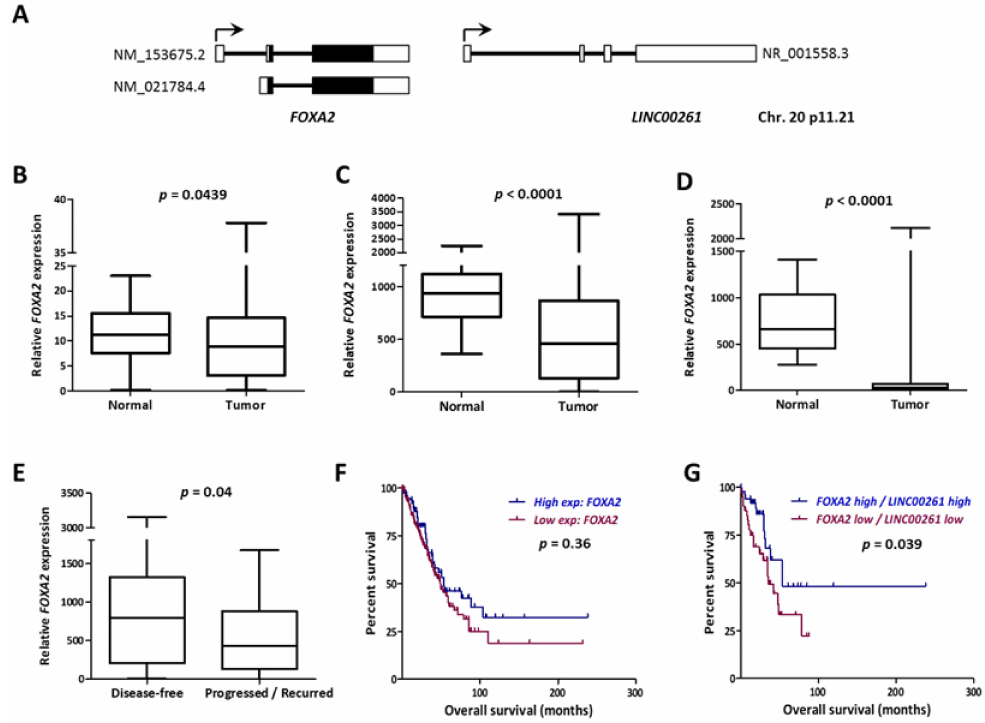
Figure 3. FOXA2 gene neighboring LINC00261 is co-downregulated in lung cancer. ( A ) The FOXA2 / LINC00261 gene locus on the small arm of human chromosome 20. Black boxes indicate coding exons and white boxes indicate non-coding exons. The accession